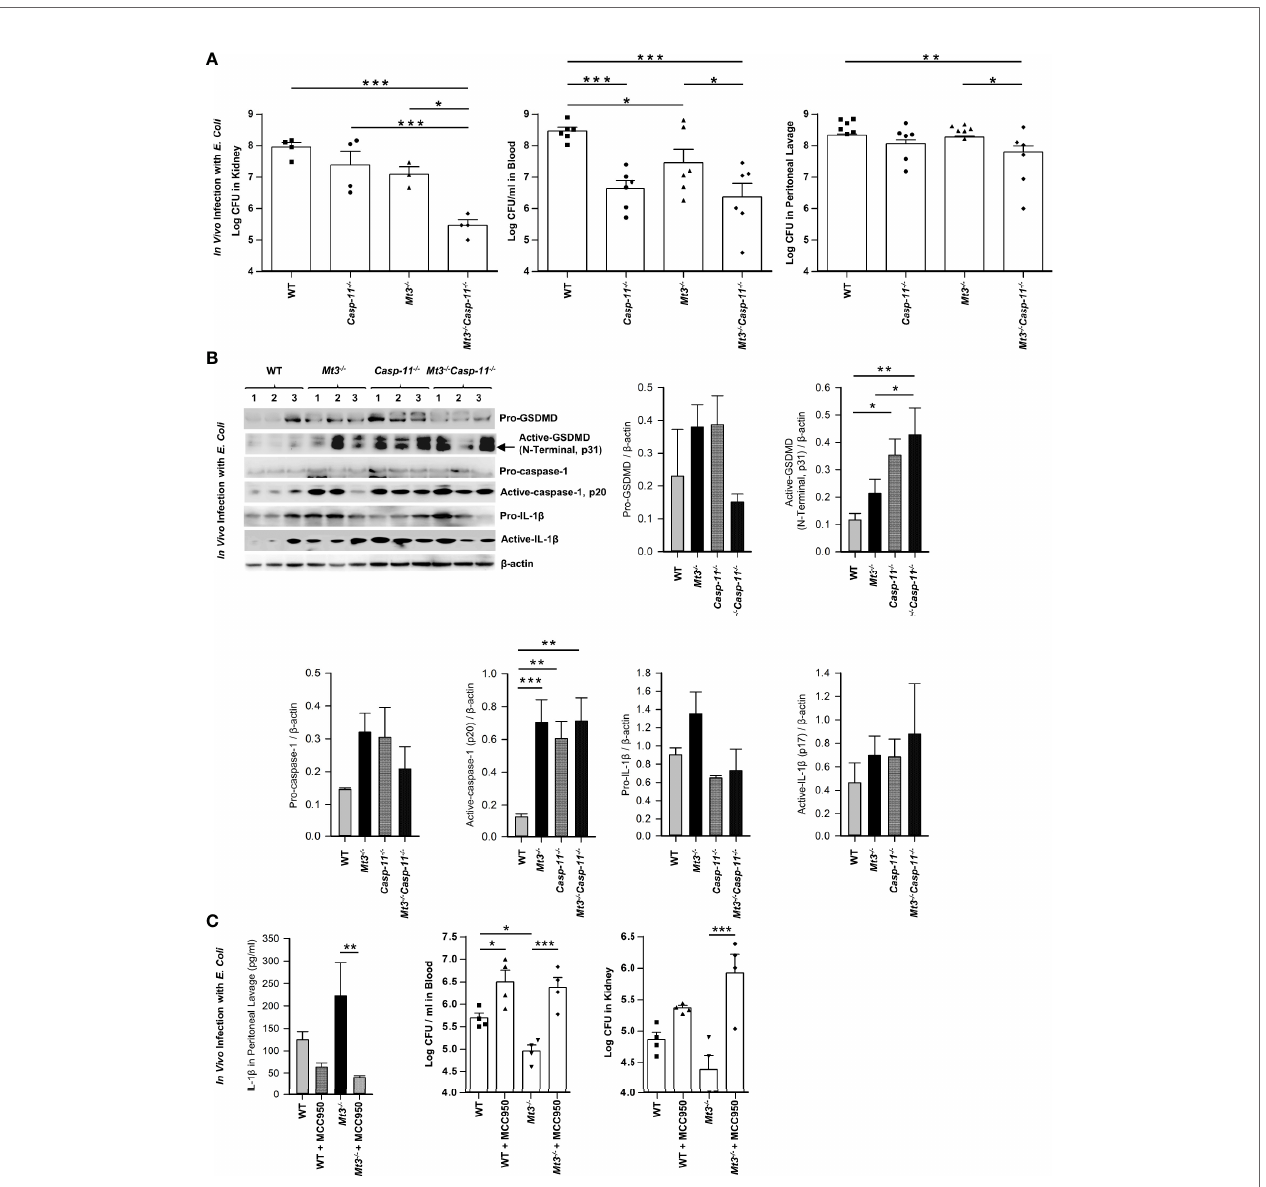
FIGURE 3 | See also Supplementary Figure S3 Caspase-11 synergizes with MT3 in impairing bacterial clearance. WT, C asp-11 -/- , Mt3 -/- and Casp-11 -/- Mt3 -/- mice were infected i.p. with E . coli (1 X10 9 CFUs/mouse) for 6h. (A) Bacterial CFUs measured in kidney, blood and peritoneal lavage, n = 3-6 per group, one-way ANOVA. (B) Western blots of pro-GSDMD, active-GSDMD (p31), pro-caspase-1, active-caspase-1, pro-IL1 b and active-IL-1 b in kidney homogenates, n = 3-6 per group, one-way ANOVA, data are mean ± SEM. (C) WT and Mt3 -/- mice treated i.p. with MCC950 (1 mg/mouse) or PBS and infected i.p. with E . coli (1 X10 9 CFUs/ mouse) for 6h. IL1 b was measured by ELISA in peritoneal lavage, n = 6 per group, one-way ANOVA, data are mean ± SEM. Bacterial CFUs in whole blood and kidney, n = 4 per group, one-way ANOVA, data are mean ± SEM. *p < 0.05, **p < 0.01, ***p <